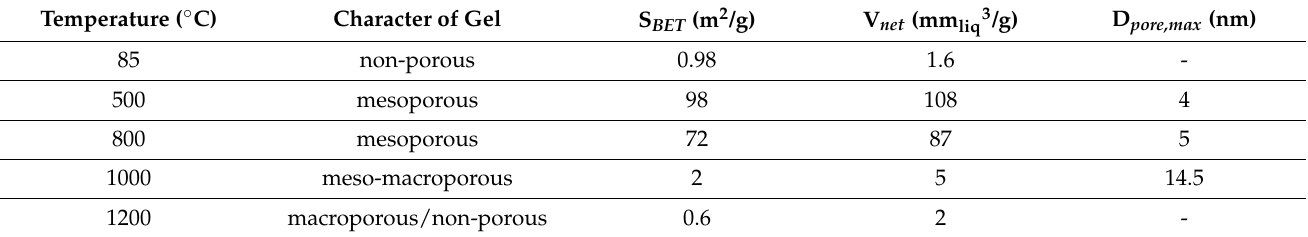
Table 2. Textural properties of gel samples at different temperatures of thermal treatment. Temperature ( ◦